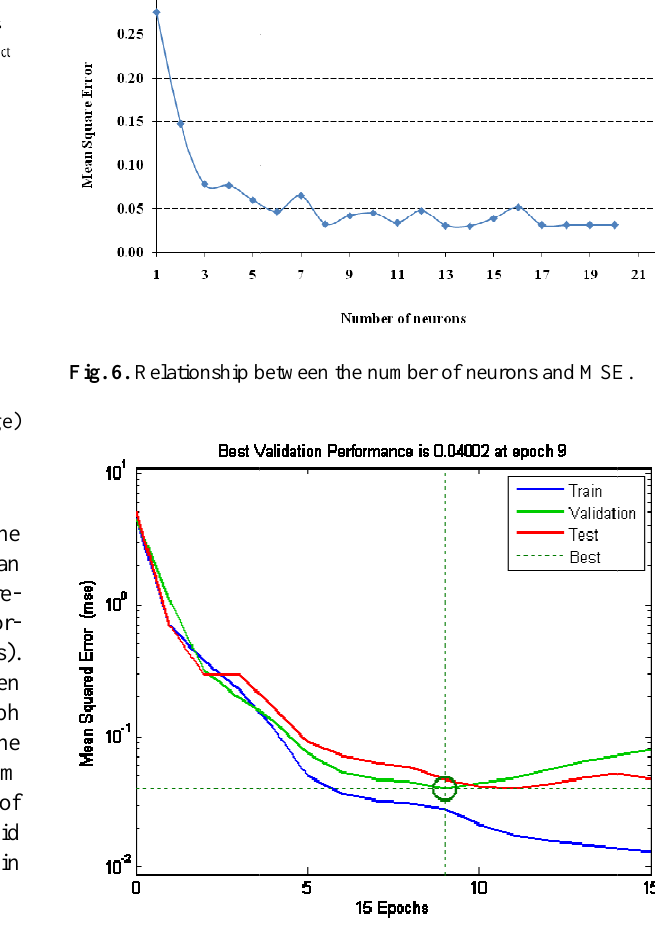
Fig. 7: Training, validation and test mean squared errors for the developed Training, validation and test mean squared errors for the developed Training, validation and test mean squared errors for the developed model Fig. 7. Training, validation and test mean squared errors for the developed